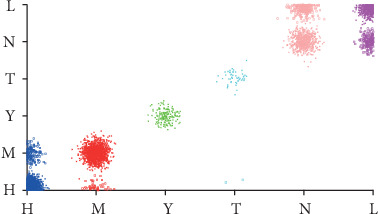
Illustration of errors of the optimized C4.5 algorithm.